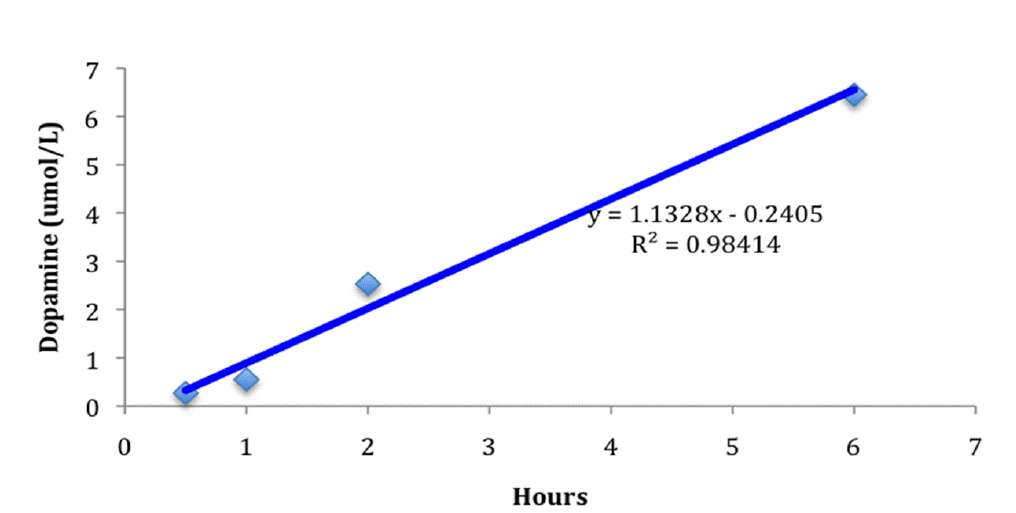
Figure 5: Time course for dopamine production with 1 mg/ml L -DOPA: concentration increased with longer incubation duration. Dopamine synthesis was linear up to the fifth time point T 4 .